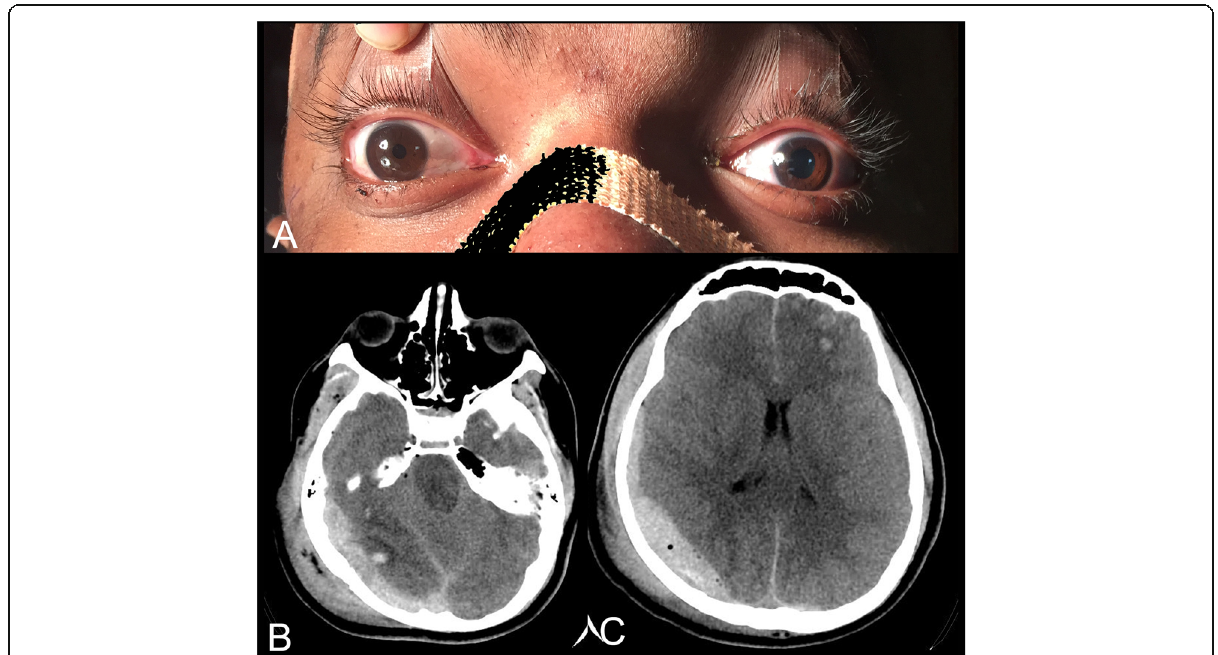
Fig. 1 a Clinical photograph showing pupillary asymmetry (left > right), left pupil was sluggishly reacting to light. b CT scan of the brain (plain) showing a large right occipito-parietal extradural hematoma, with underlying contusion (please note the compression and gross distortion of the brainstem). c Contrecoup left frontal polar patchy